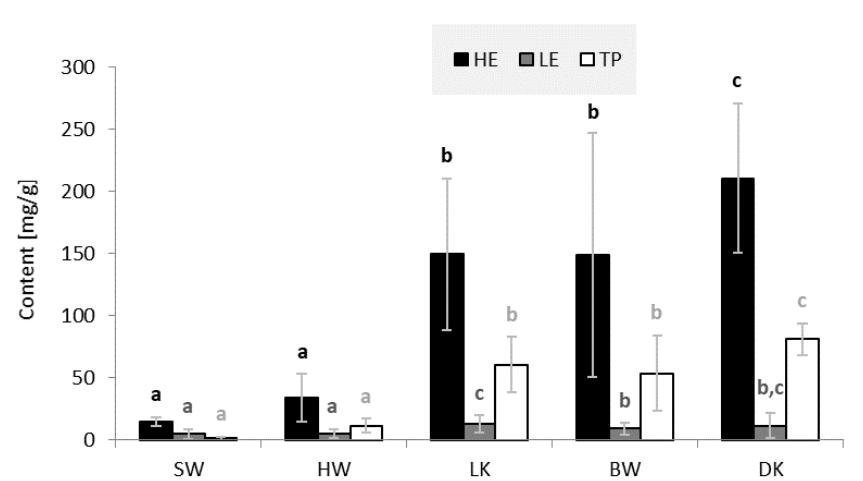
Figure 2. Content of and hydrophilic extractives (HE, acetone-soluble compounds), lipophilic extractives (LE, cyclohexane-soluble compounds) and total phenols (TP) in sapwood (SW), heartwood (HW), wood of living knots (LK), wood of branches (BW) and wood of dead knots (DK) of silver fir ( A. alba ). a–c Different letters on the error bars of the same series of columns indicate statistically significant differences at a 95% confidence level (LSD test).